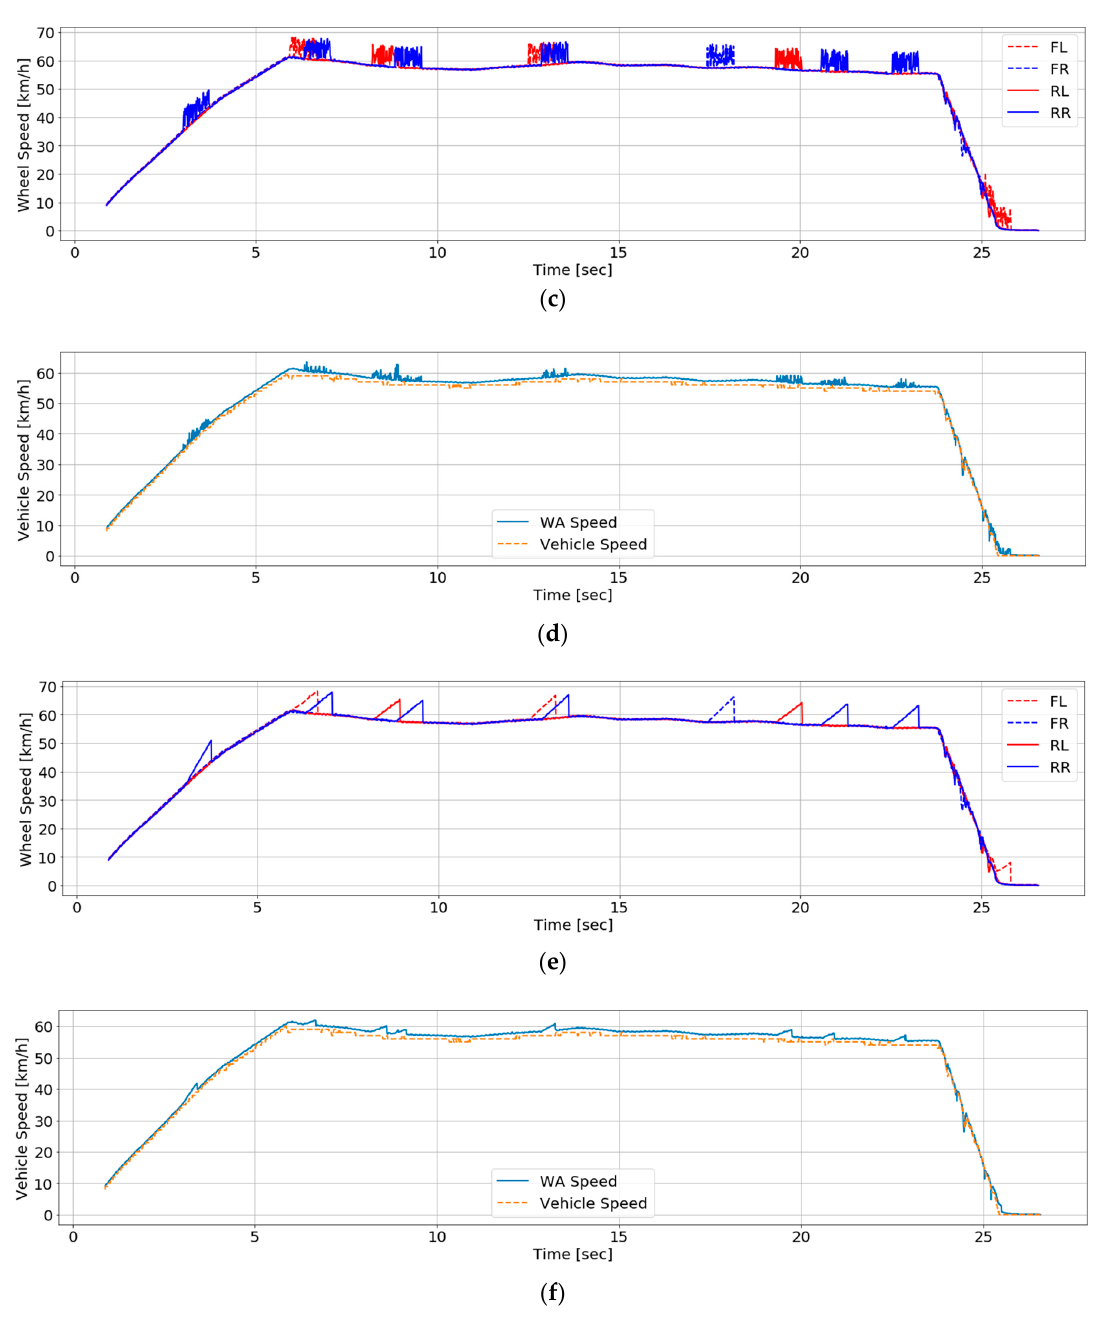
Figure 7. Datasets inject false data: ( a ) Four wheel speed data to consider additive attacks; ( b ) Estimated speed against additive attacks and reference speed data; ( c ) Four wheel speed data to consider random attacks ( d ) Estimated speed against random attacks and reference speed data; ( e ) Four wheel speed data to consider drift attacks; ( f ) Estimated speed against drift attacks and reference speed data. Table 10. Test accuracies.